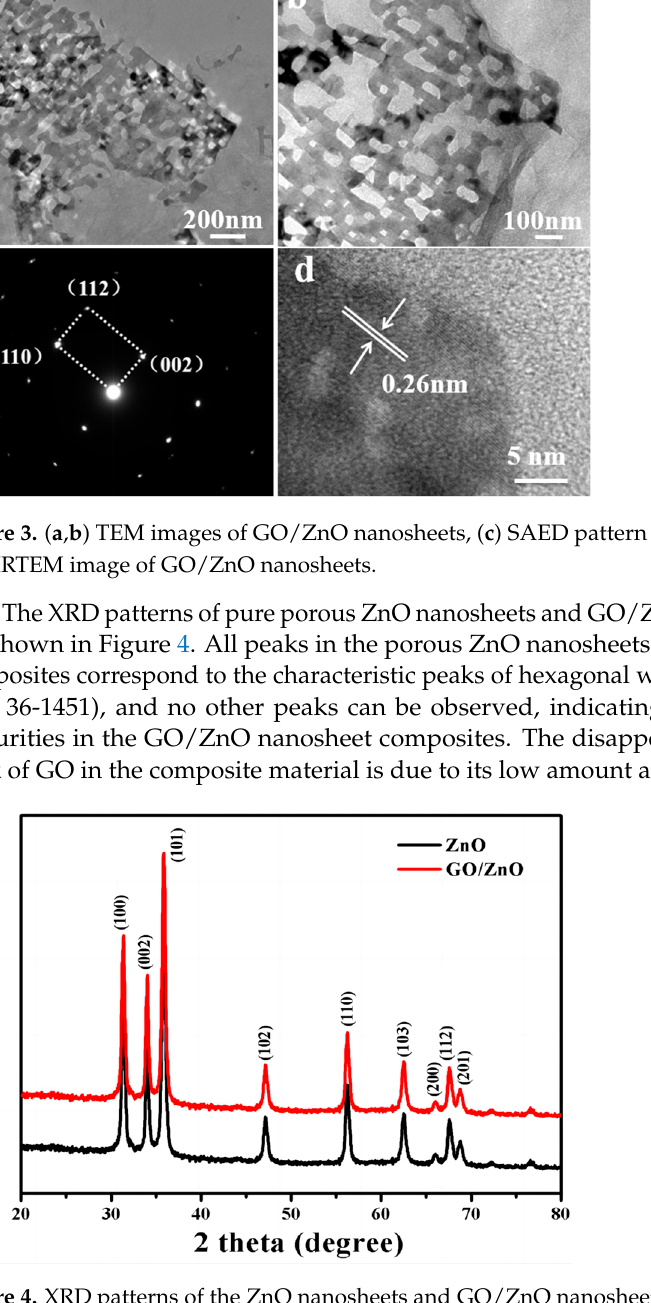
Figure 4. XRD patterns of the ZnO nanosheets and GO/ZnO nanosheet composites.